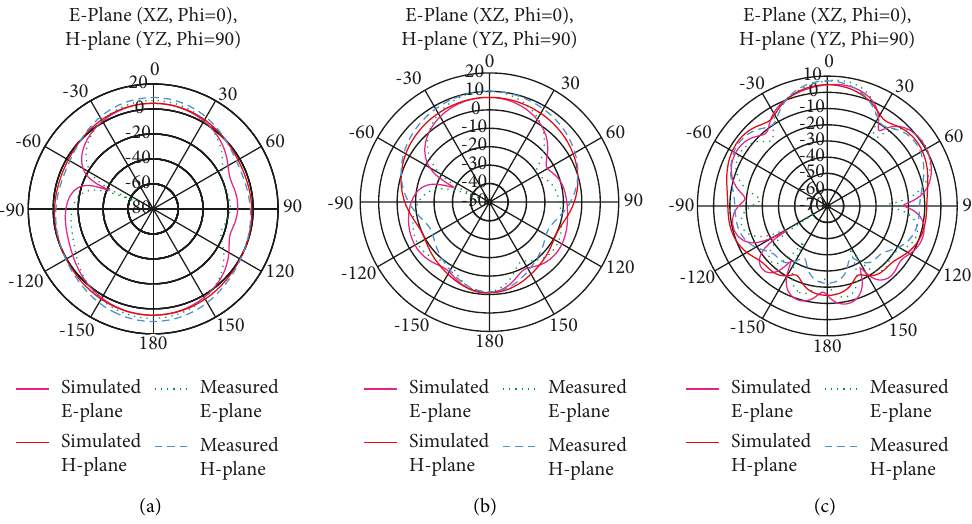
Figure 10: E -plane and H -plane of FSS-based UWB antenna at (a) 3.1GHz, (b) 5.3GHz, and (c) 9GHz.